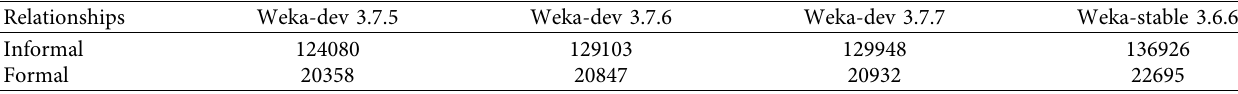
Table 22: Formal and informal relationships in weka.